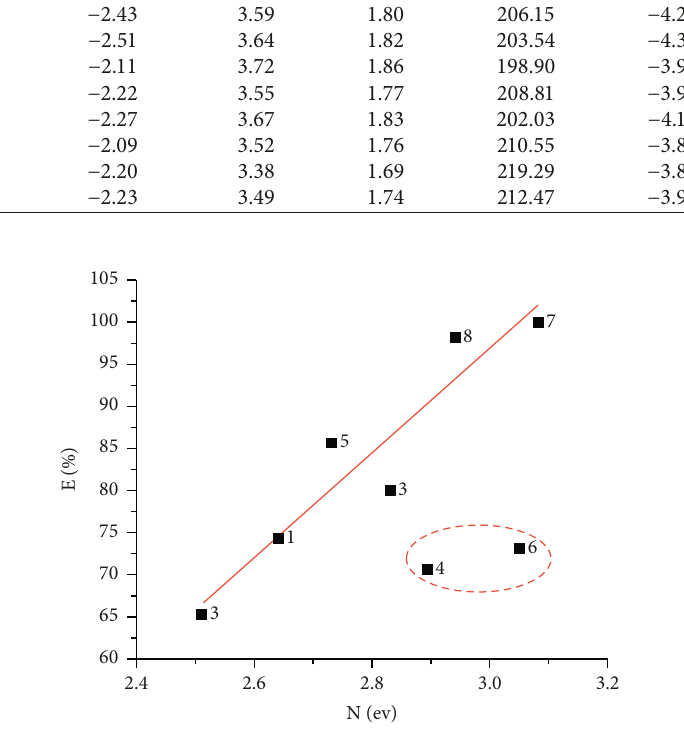
Figure S1: FTIR spectrum of 1 . Figure S2: FTIR spectrum of 2 . Figure S3: FTIR spectrum of 3 . Figure S4: FTIR spectrum of 4 . Figure S5: FTIR spectrum of 5 . Figure S6: FTIR spectrum of 6 . Figure S7: FTIR spectrum of 7 . Figure S8: FTIR spectrum of 8 . Figure S9: 1 H NMR spectrum of 1 . Figure S10: 1 H NMR spectrum of 2 . Figure S11: 1 H NMR spectrum of 3 . Figure S12: 1 H NMR spectrum of 4 . Figure S13: 1 H NMR spectrum of 5 . Figure S14: 1 H NMR spectrum of 6 . Figure S15: 1 H NMR spectrum of 7 . Figure S16: 1 H NMR spectrum of compound 8 . ( Supplementary Materials )